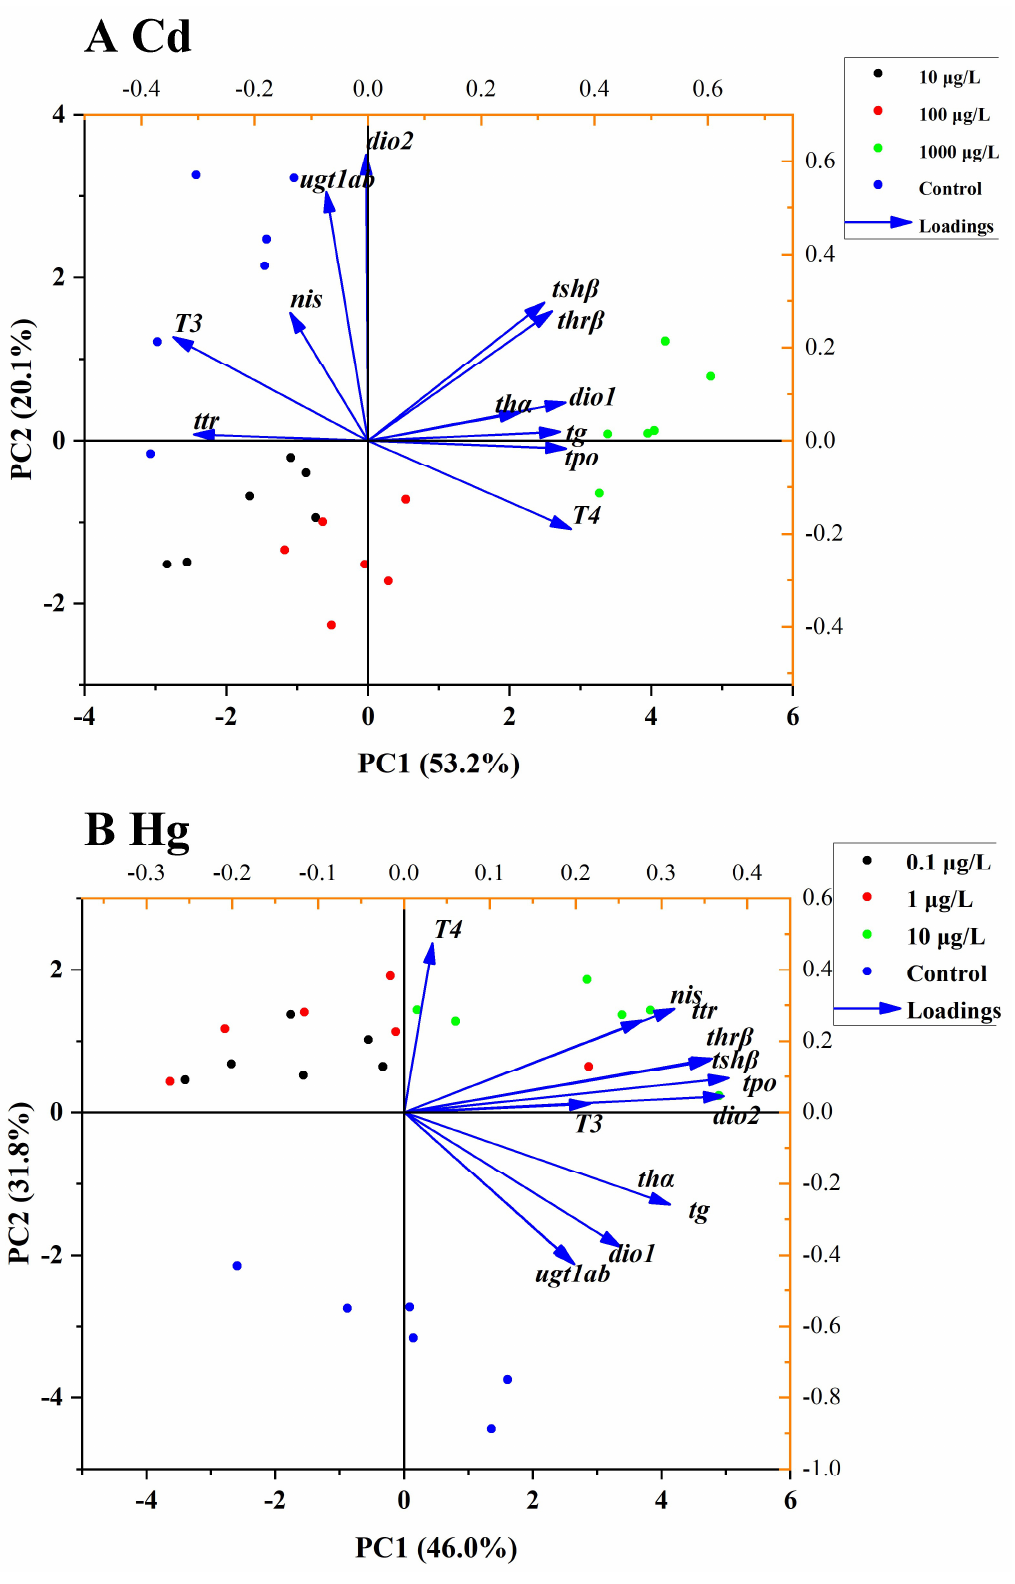
Figure 3. Principal component analysis (PCA) of parameters in zebrafish embryos (2 hpf) that were treated with Cd 2+ (0, 10, 100, and 1000 µ g/L) ( A ) and Hg 2+ (0, 0.1, 1, and 10 µ g/L) ( B ) for 120